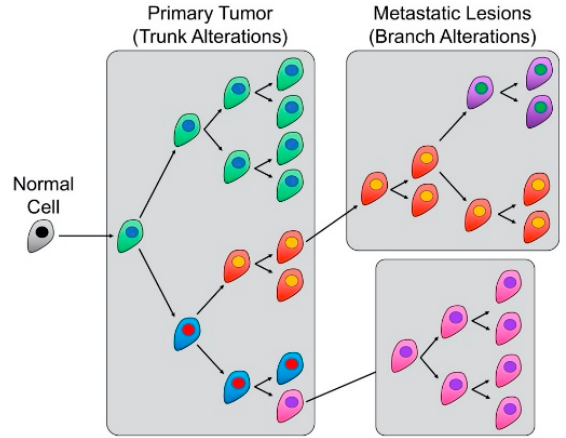
Figure 2. CIN drives trunk and branch alterations to contribute to tumor evolution and metastasis. Illustration showing the tree-like ‘trunk’ and ‘branch’ alterations driven by CIN. In general, trunk alterations are early events that are conserved in all subsequent cellular progeny, whereas branch alterations are subsequent genetic alterations that direct clonal evolution and intratumoral heterogeneity to drive disease progression, metastasis, and drug resistance. Note that the color changes coincide with cells that have accrued additional genetic alterations (e.g., CIN).